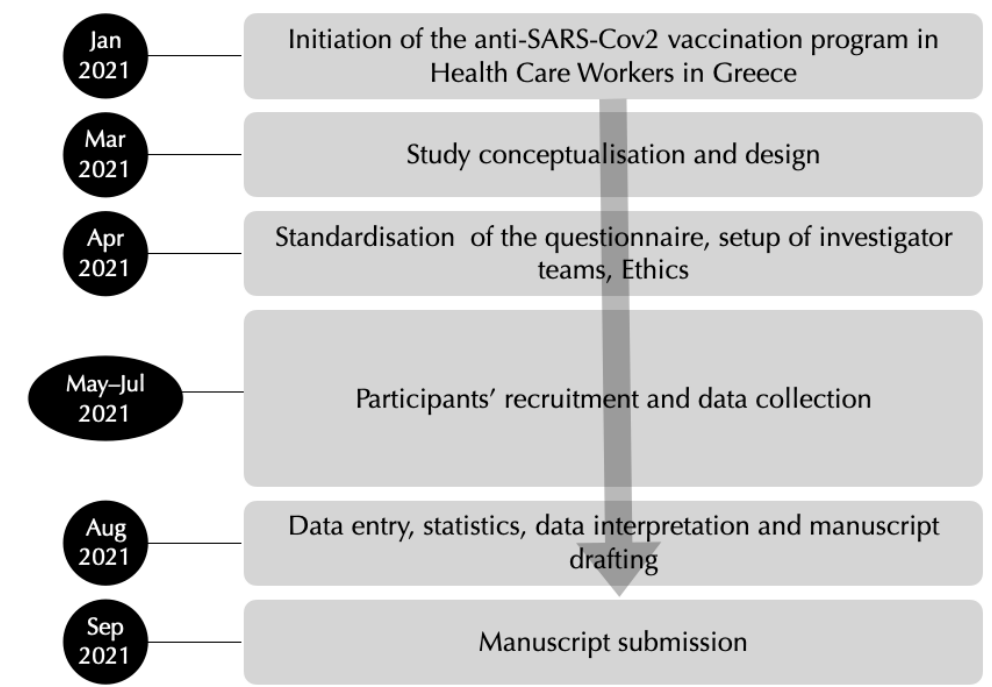
Figure 1. Flow diagram of the study. Table 1. The Q-No questionnaire.